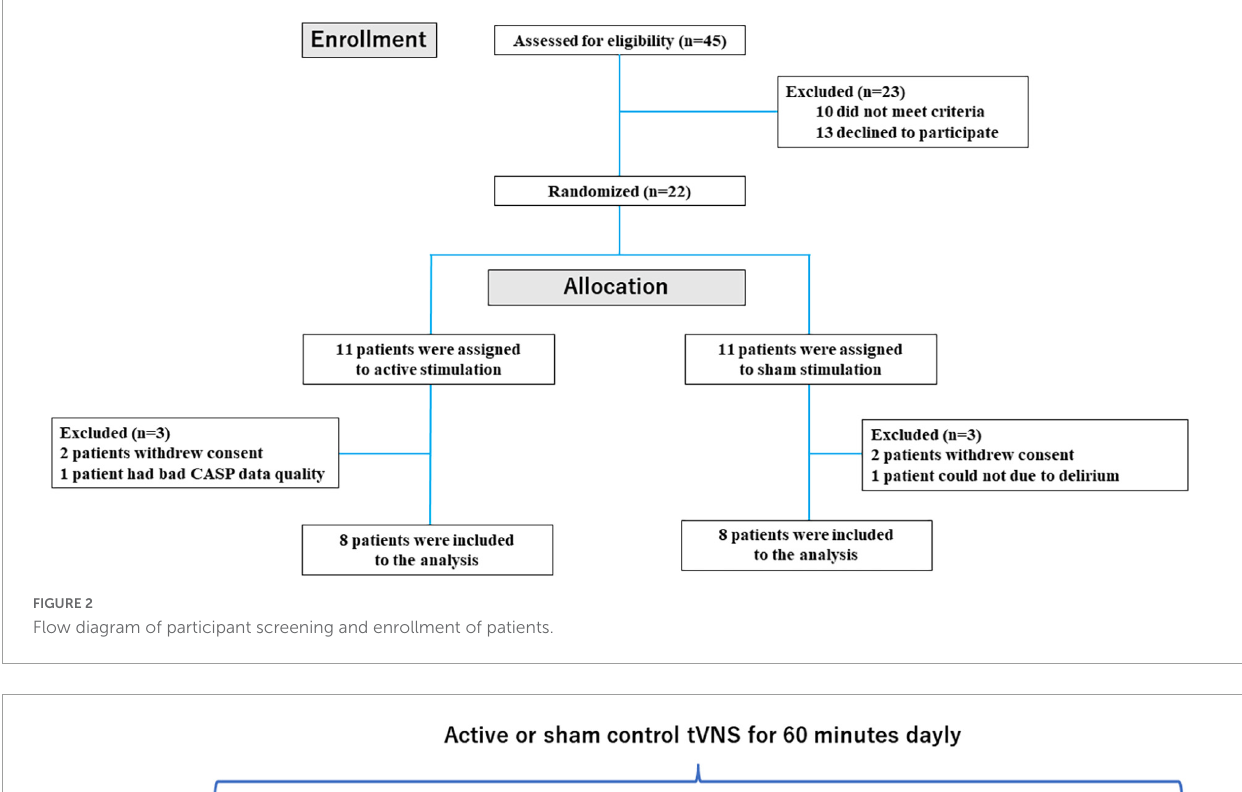
FIGURE2 Flow diagram of participant screening and enrollment of patients.